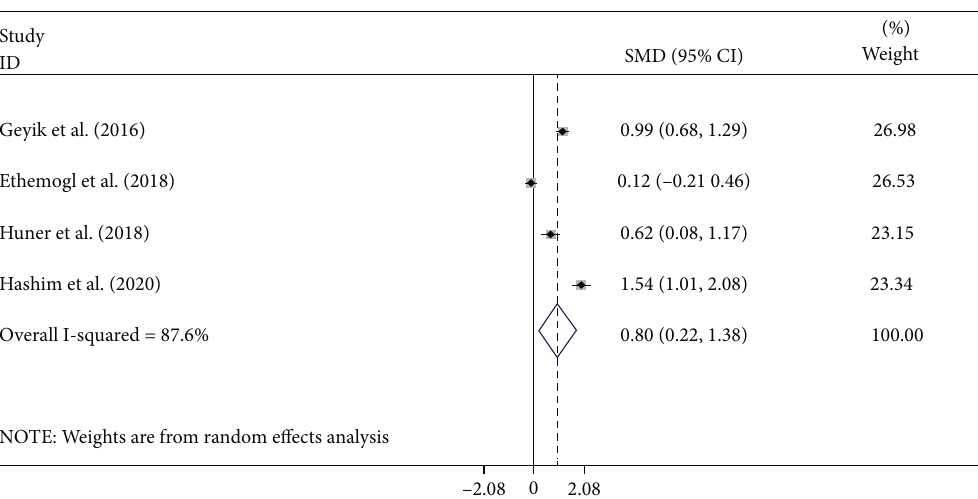
Figure 6: Meta-analysis of di ff erences in NLR levels between pre- and posttreatment e ff ects model, SMD = 0 : 80 , 95 % CI = 0 : 22 to 1.38, P < 0 : 001 ) (Figure 6).